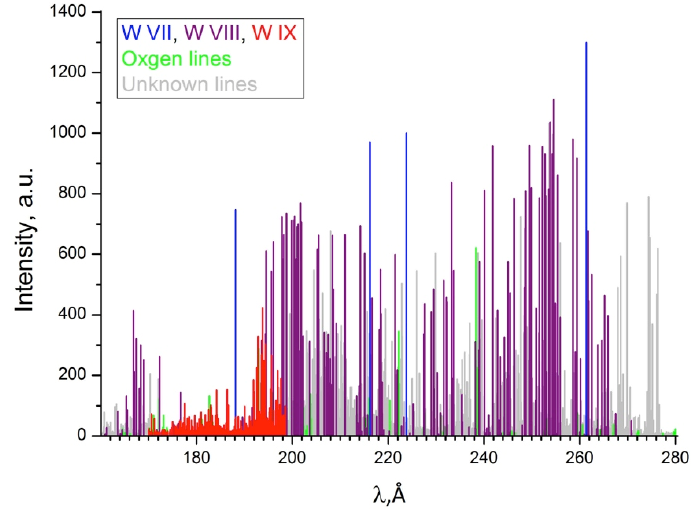
Figure 3. Spectrum of tungsten excited in a vacuum spark with the peak current 50 kA with identification of the